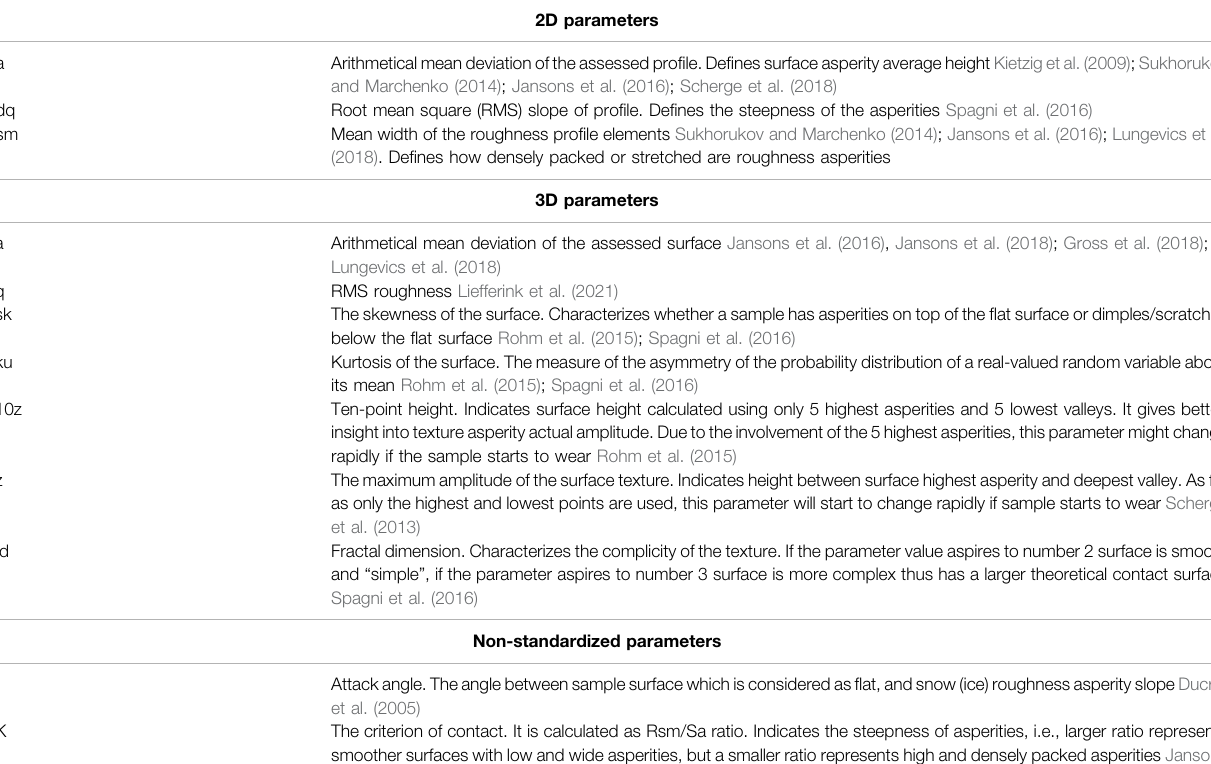
TABLE 2 | Texture parameters used in the existing ice tribology studies.